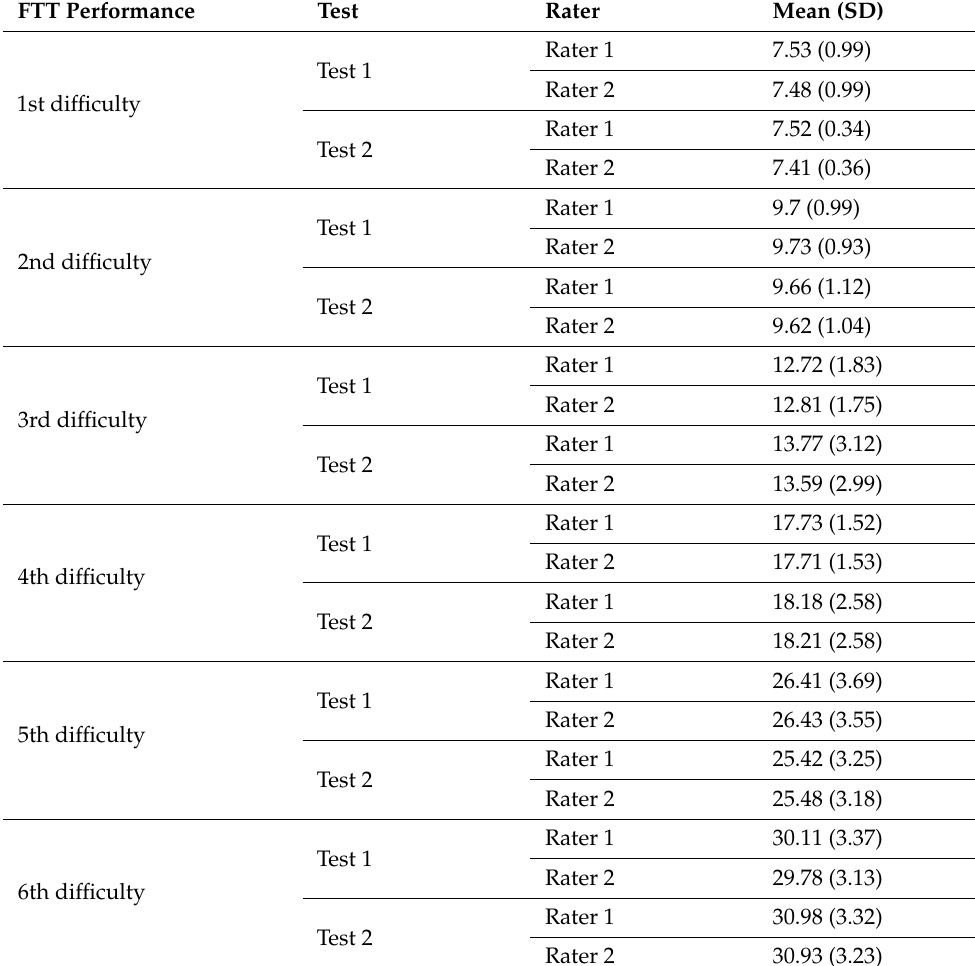
Table 2. Intrarater and interrater reproducibility of the FTT in healthy